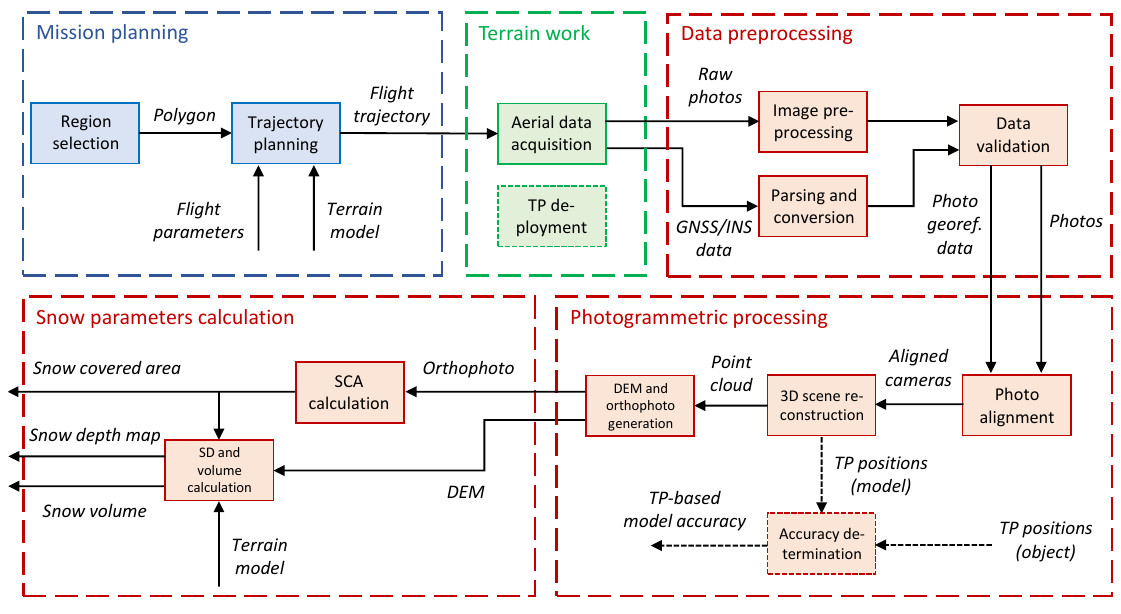
Figure 4. The workflow illustrating the entire snow-field monitoring procedure. TP—test point; GNSS— global navigation satellite system; INS—inertial navigation system; DEM—digital elevation model; SCA—snow-covered area; SD—snow